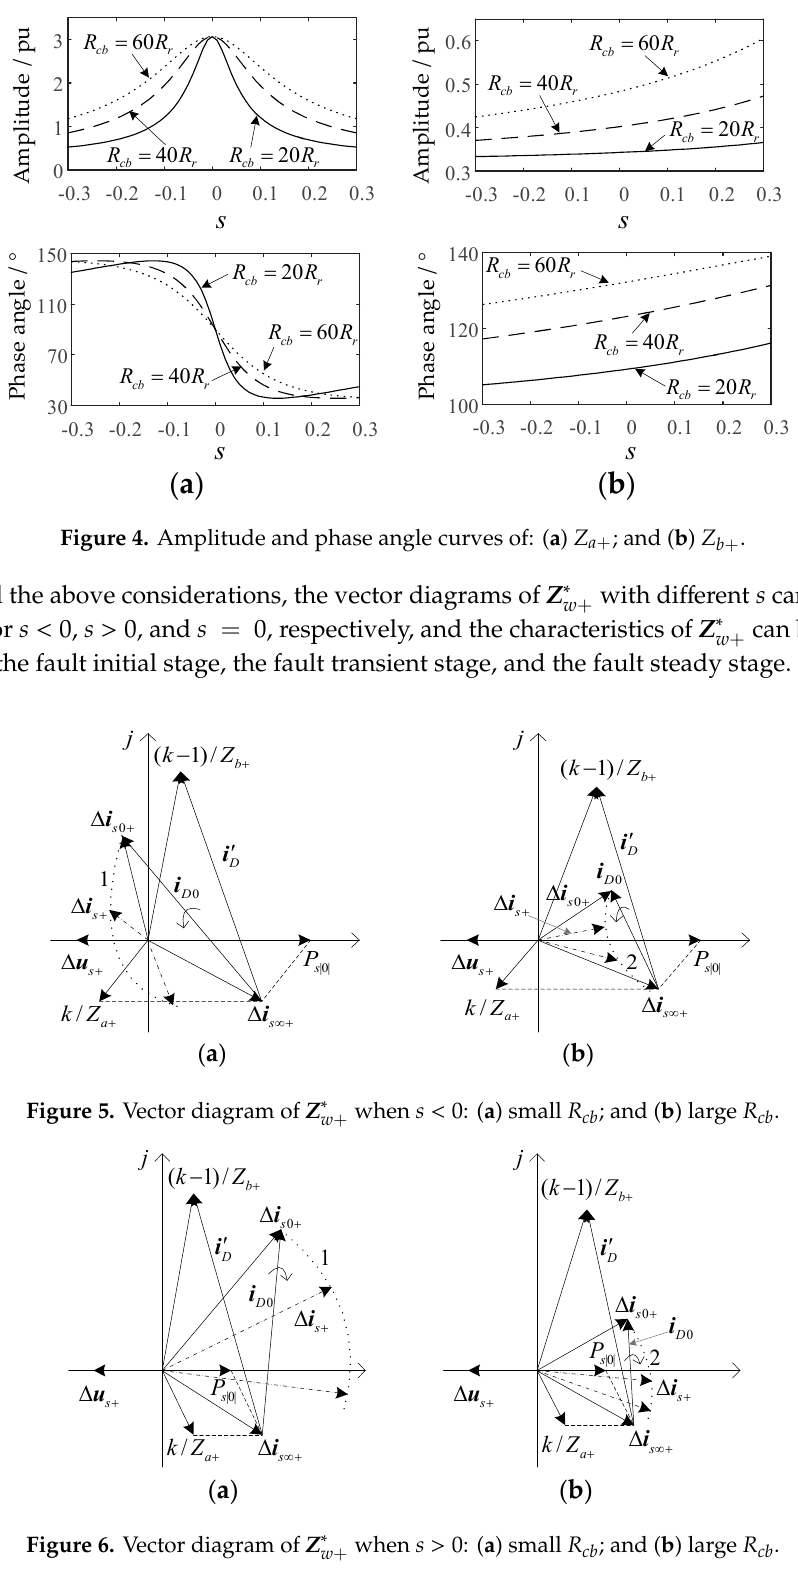
and ∆ ϕ < 0. Particularly, when s = 0, there is ∆ A ≈ 1 and ∆ ϕ ≈ 0. Another point deserves noting in (cid:48) Figure A1 is that a large value of T r (i.e., a large crowbar resistance is used for DFIG) will result in a small value of ∆ A and ∆ ϕ .